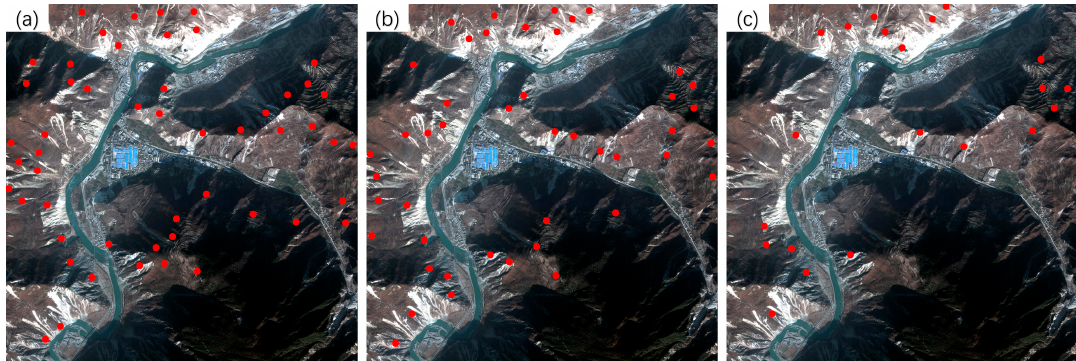
Figure 11. Matched tie points obtained from the Wenchuan dataset. ( a ) The proposed method; ( b ) Patch- scale-invariant feature transform (SIFT); and ( c ) SIFT.